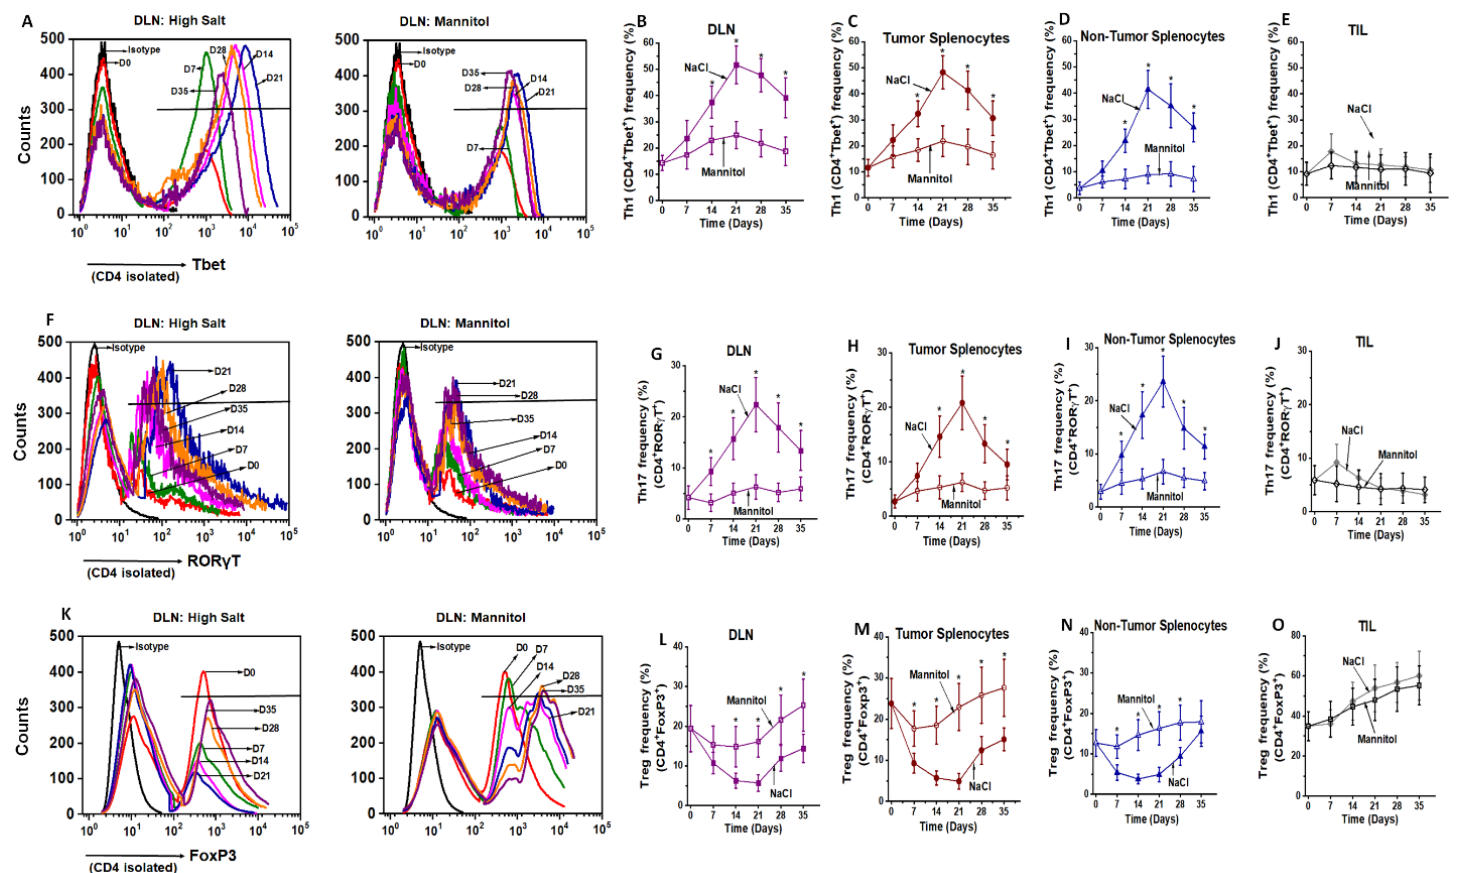
Figure 2. Changes in the effector and suppressive phenotype following ex vivo expansion of CD4+T cells. ( A – E ) Flow cytometry analysis of Tbet (Th1) expression of CD4+T cells on day 7, 14, 21, 28 and 35 to study the impact of stimulation cycles (S1–S5, respectively). Isotype is used as negative control and day 0 is used to obtain the baseline phenotype frequencies. CD4+T cells were obtained from DLNs ( A ); Quantitative temporal changes in Tbet (Th1) expression in DLNs ( B ), tumor-splenocytes ( C ), non-tumor splenocytes ( D ) and TILs ( E ) which were subjected to high salt ( ∆ 0.035 M NaCl, filled symbols) or equimolar mannitol (0.035 M mannitol, treatment control, open symbols); ( F – J ) flow cytometry ( F ) and temporal changes in ROR γ T (Th17) expression ( G – J ) following treatment with high salt and mannitol treatment on CD4+T cells obtained from DLNs ( G ), tumor-splenocytes ( H ), non-tumor splenocytes ( I ) and TILs ( J ); flow cytometry ( K ) and temporal changes (L–O) of FoxP3 (Treg) expression following treatment with high salt and mannitol treatment on CD4+T cells obtained from DLNs ( L ), tumor-splenocytes ( M ), non-tumor splenocytes ( N ) and TILs ( O ). Data obtained from 5 independent measurements and presented as mean ± SEM; (*) p <